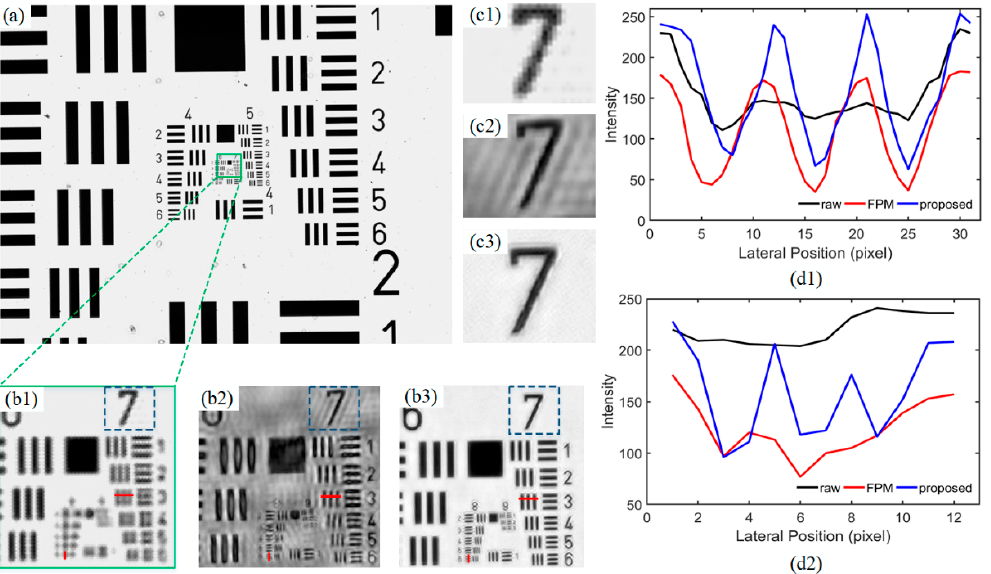
Figure 5. Resolution characterization of the implemented FPM platform. ( a ) The full field of view (FOV) of the USAF target recorded with the implemented platform. ( b1 – b3 ) An enlargement of the subregion in Figure ( a ), the reconstructed high-resolution (HR) intensity image with conventional FP algorithm, and the HR image recovered with SA-embedded FP algorithm, respectively. ( c1 – c3 ) Enlargements of the content inside the blue boxes in Figure ( b1 – b3 ). ( d1 – d2 ) Intensity profiles of the red lines (element 3, group 7 and element 5, group 8) shown in ( b1–b3 ).